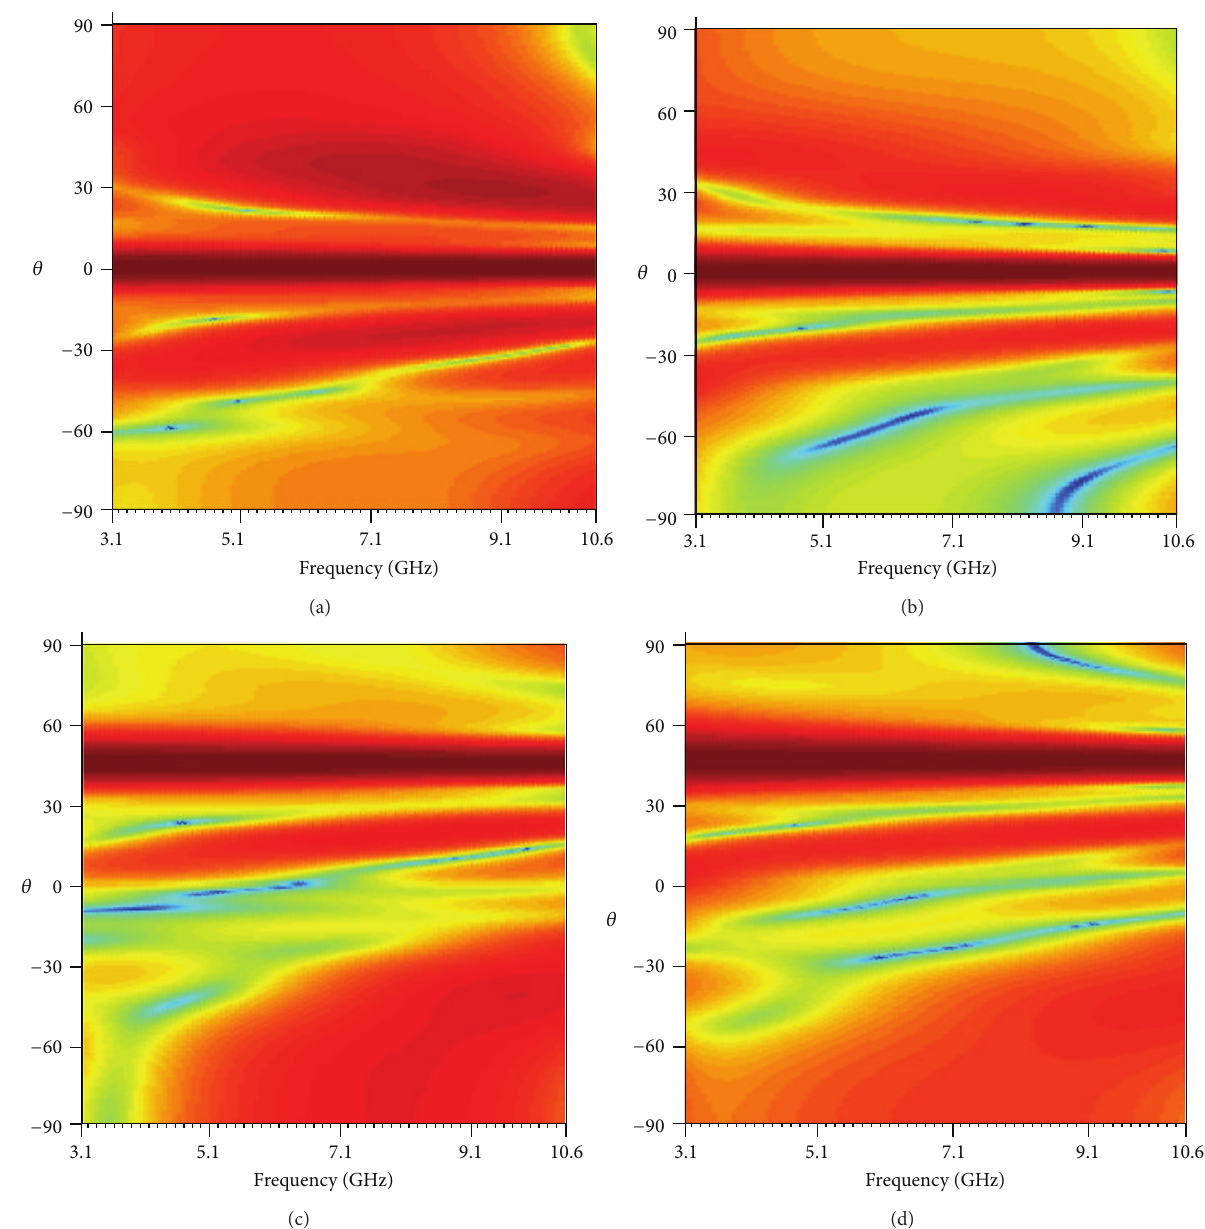
Figure 8: Spectrum in frequency of (a) CCRA at 𝜃 = 0 ∘ , (b) UCRA at 𝜃 = 0 ∘ , (c) CCRA at 𝜃 = 45 ∘ , and (d) UCRA at 𝜃 = 45 ∘ .